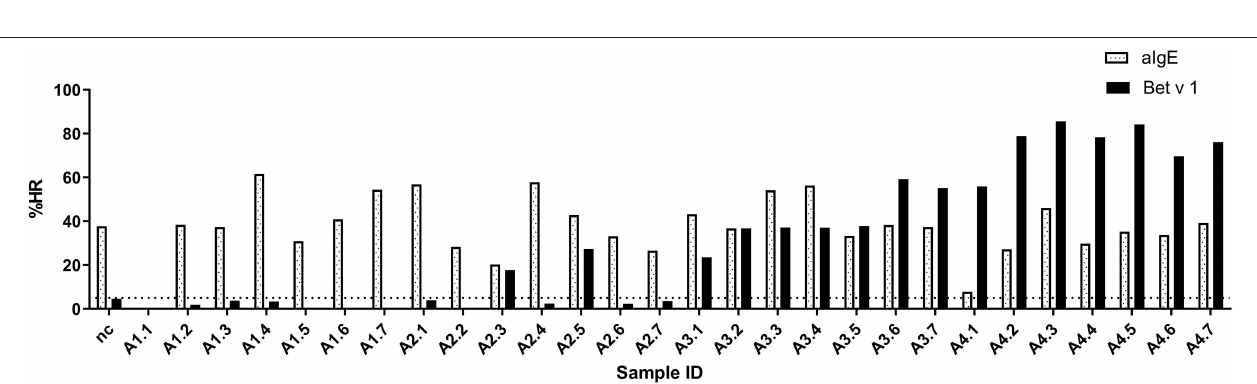
FIGURE 4 | PS basophils activated by matrix fixed allergen using Bet v 1 or anti-IgE (assay control) ImmunoCAP TM . Released histamine was extracted and quantified. Dotted horizontal line at 5% indicates background; nc, negative control.